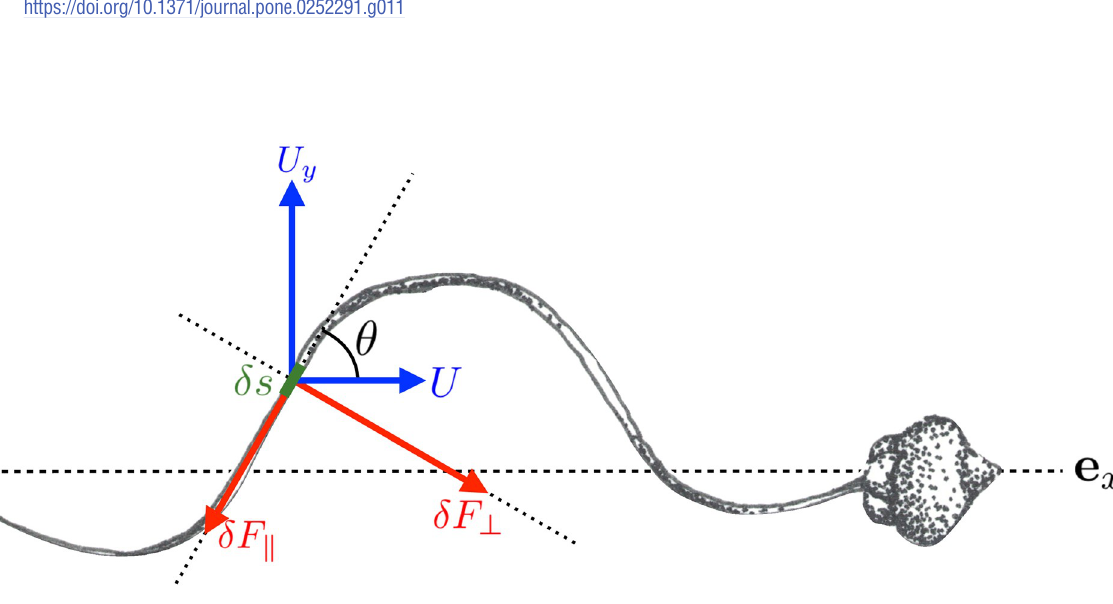
Fig 12. Sketch of a swimming eukaryote (spermatozoon of Chaetopterus , Annelida) propelled by a single flagellum. We distinguish a section of , which we use to determine the local hydrodynamic forces exerting on the flagellum. length δ s inclined at an angle θ to the direction of motion e x Drawing by Marcos F. Velho